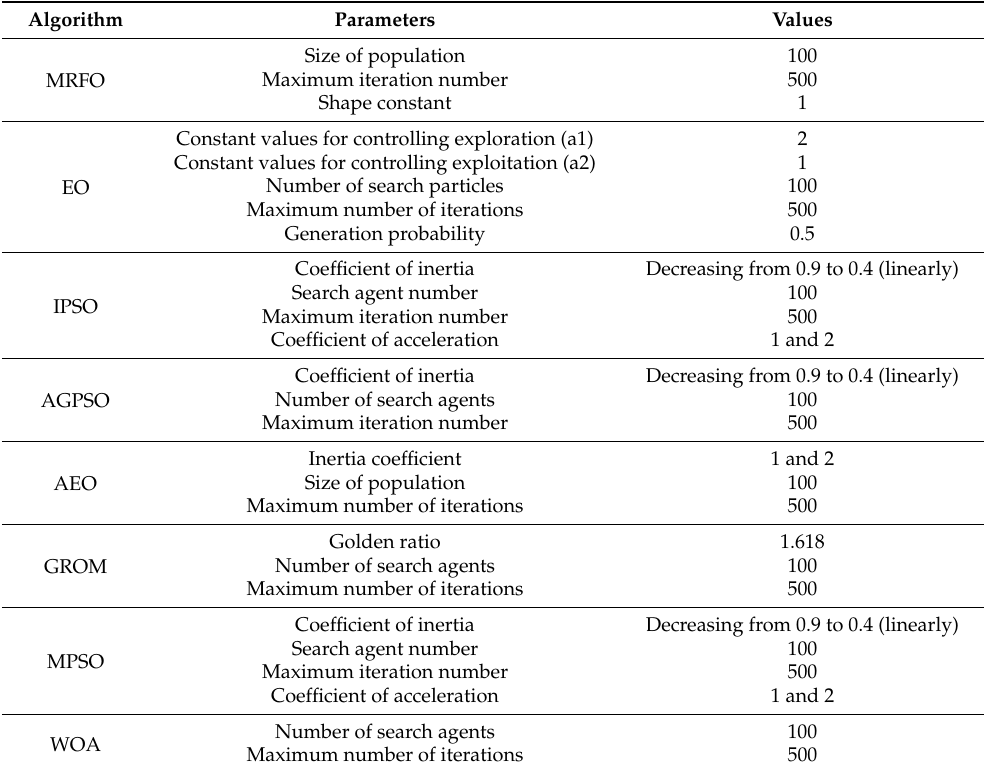
Table 3. The main parameters of the optimization